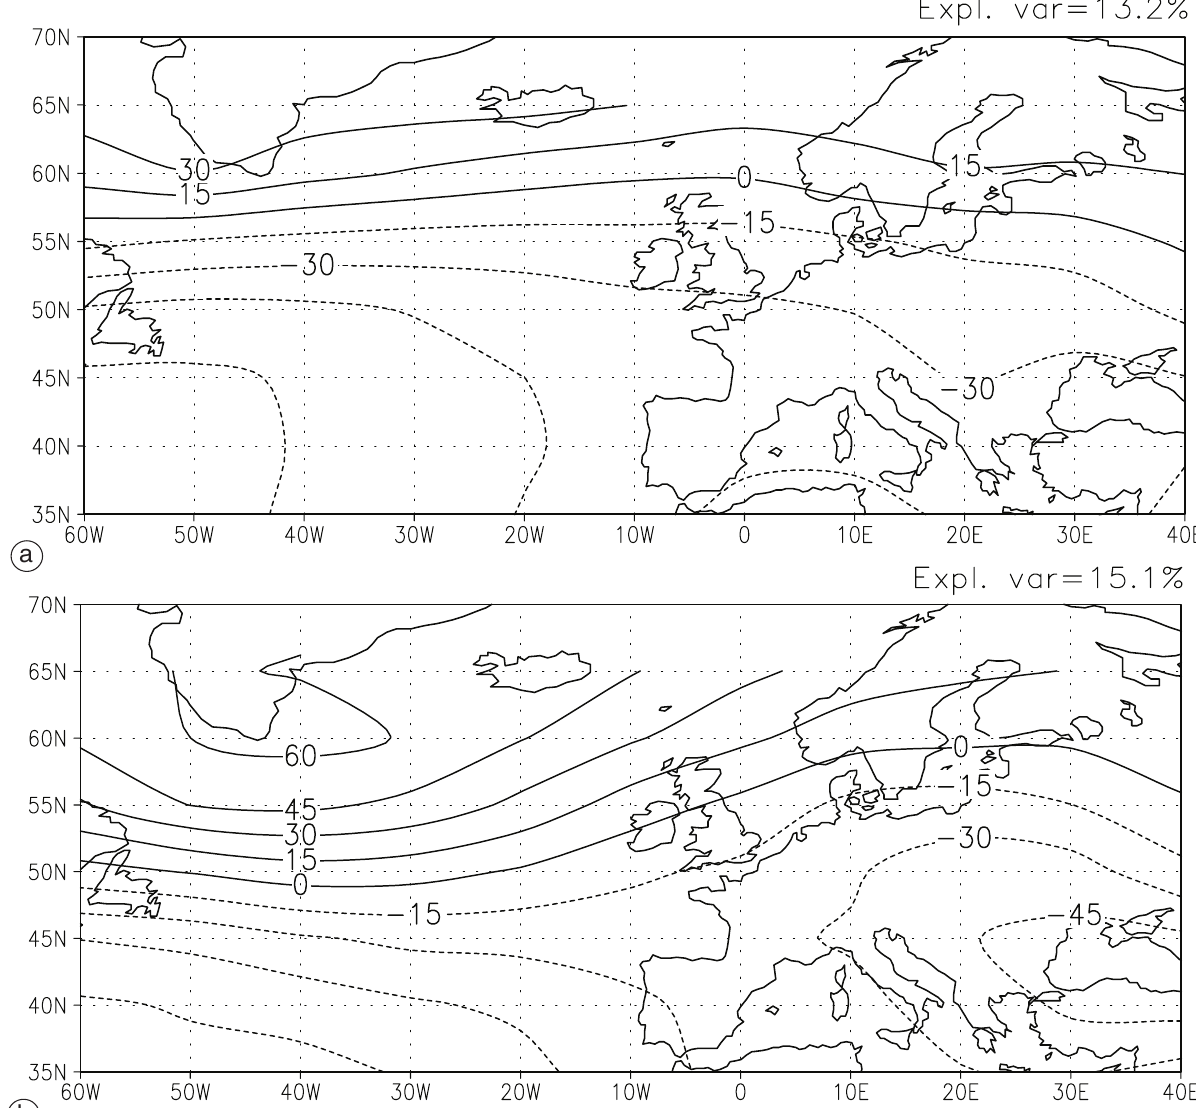
Fig. 12a,b. Leading MSLP heterogeneous correlation patterns from SVD analyses of two different 46-year periods of gridded observations of JFM seasonal mean tropical SST and JFM seasonal mean Atlantic/European MSLP. a) For 1903-1948; b) for 1949-1994. Cf . fig. 1a which is based on an SVD analysis of all 92